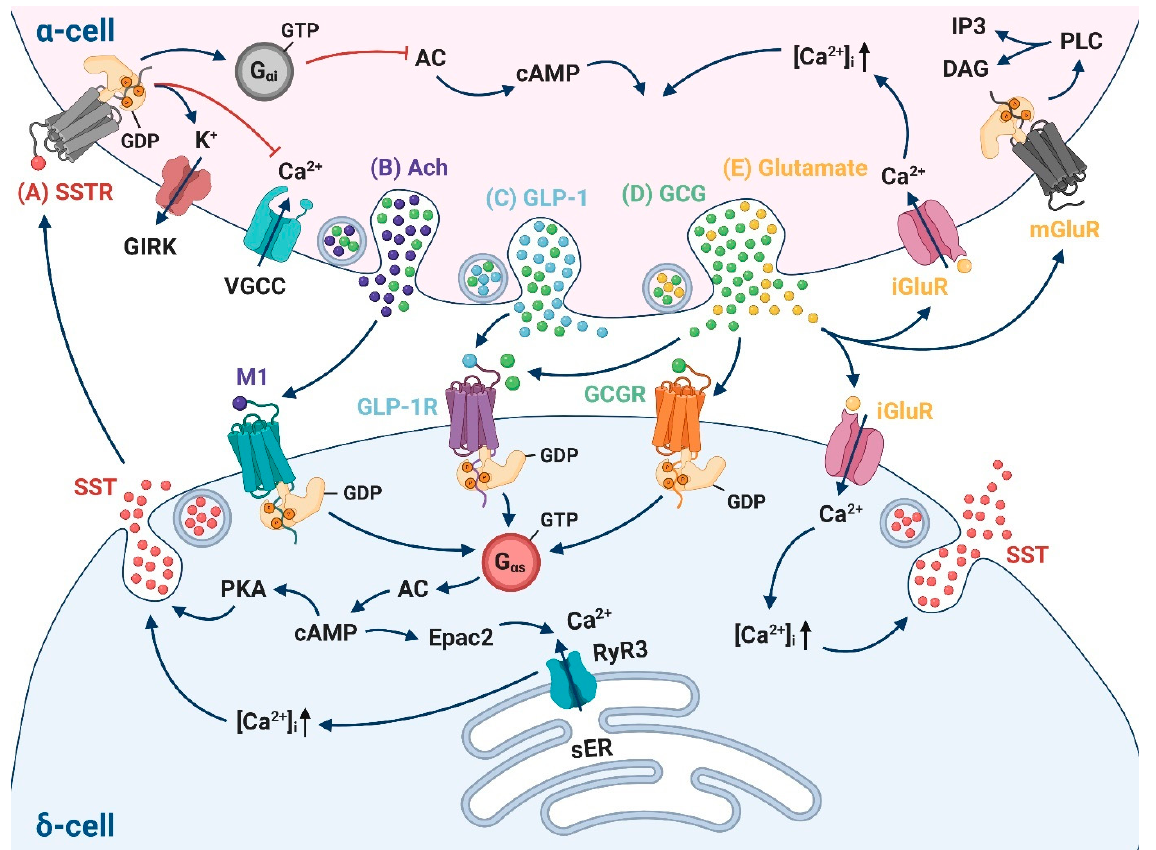
Figure 4. Paracrine interaction between α -cells and δ -cells. ( A ) The downstream signaling of somatostatin (SST, red) activation of somatostatin receptor (SSTR) on α -cells involves activating the coupled G α i protein, leading to decreased cytoplasmic levels of cAMP; hyperpolarizing the membrane potential and inhibiting action potential firing via G protein- coupled inwardly rectifying K + (GIRK) channels; inhibiting Ca 2+ influx through voltage-gated P/Q-type Ca 2+ channels. ( B – D ) The stimulatory effect of Ach (purple, co-secreted with glucagon, which is marked as green), GLP-1 (blue, co-secreted with glucagon, which is marked as green) and GCG (green) on somatostatin secretion is mediated via Ach receptor M1, GLP-1R and GCGR, respectively. All these receptors are G α s -coupled receptors which subsequently activate adenylate cyclase (AC), increase cAMP production and trigger PKA-potentiated δ -cell exocytosis. ( E ) Glutamate (yellow) is co-secreted with glucagon (green). In α -cells, it acts as an autocrine feedback signal potentiating adequate glucagon release through ionotropic glutamate receptors (iGluRs), whereas its inhibitory role is conducted via metabotropic glutamate receptors (mGluRs). In δ -cells, the pathways following the activation of iGluR might share some similarities with glutamate effect on α -cells, including membrane depolarization, opening of voltage-gated Ca 2+ channels (VGCC), increase in cytoplasmic [Ca 2+ ] i and enhanced somatostatin secretion. RyR3, ryanodine receptor 3; cAMP, cyclic AMP; PKA, protein Kinase A; PLC, phospholipase C; IP3, inositol trisphosphate; DAG, diacyl glycerol; sER, smooth endoplasmic reticulum; Ach, acetylcholine; GLP-1, glucagon-like peptide-1; GLP-1R, glucagon-like peptide-1 receptor; GCG, glucagon; GCGR, glucagon receptor; SST, somatostatin. Created by BioRender.com.